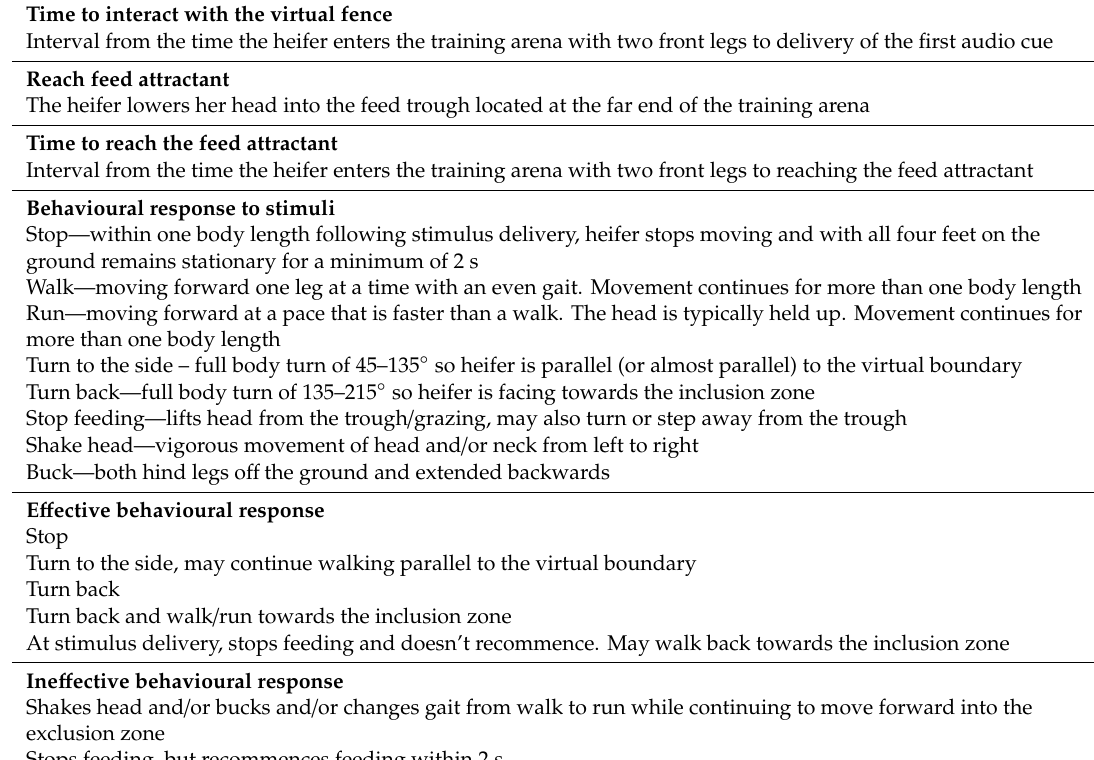
Table 1. Ethogram of cattle behaviours recorded during associative training. Intra-observer